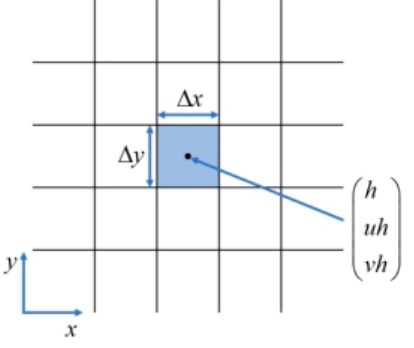
Figure 8. Spatial discretization of cell-centered finite volume scheme.